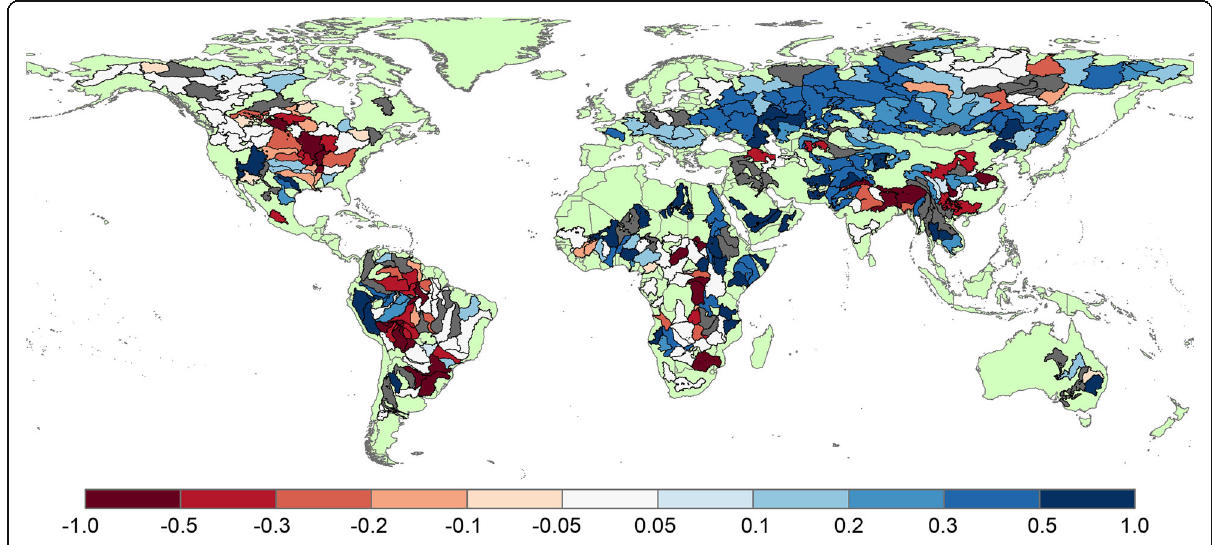
Fig. 2 The same as Fig. 1, but for the mean FAR 50 during 2010-2013 at the lowest point of each sub-catchment. The average of the result from two NAT experiments (NAT-dtr and NAT-cmip5) is plotted when FAR 50 between these experiments shows the same effect direction. White shows sub-catchments with different directions of change, while colors show small FAR 50 values between − 0.05 and